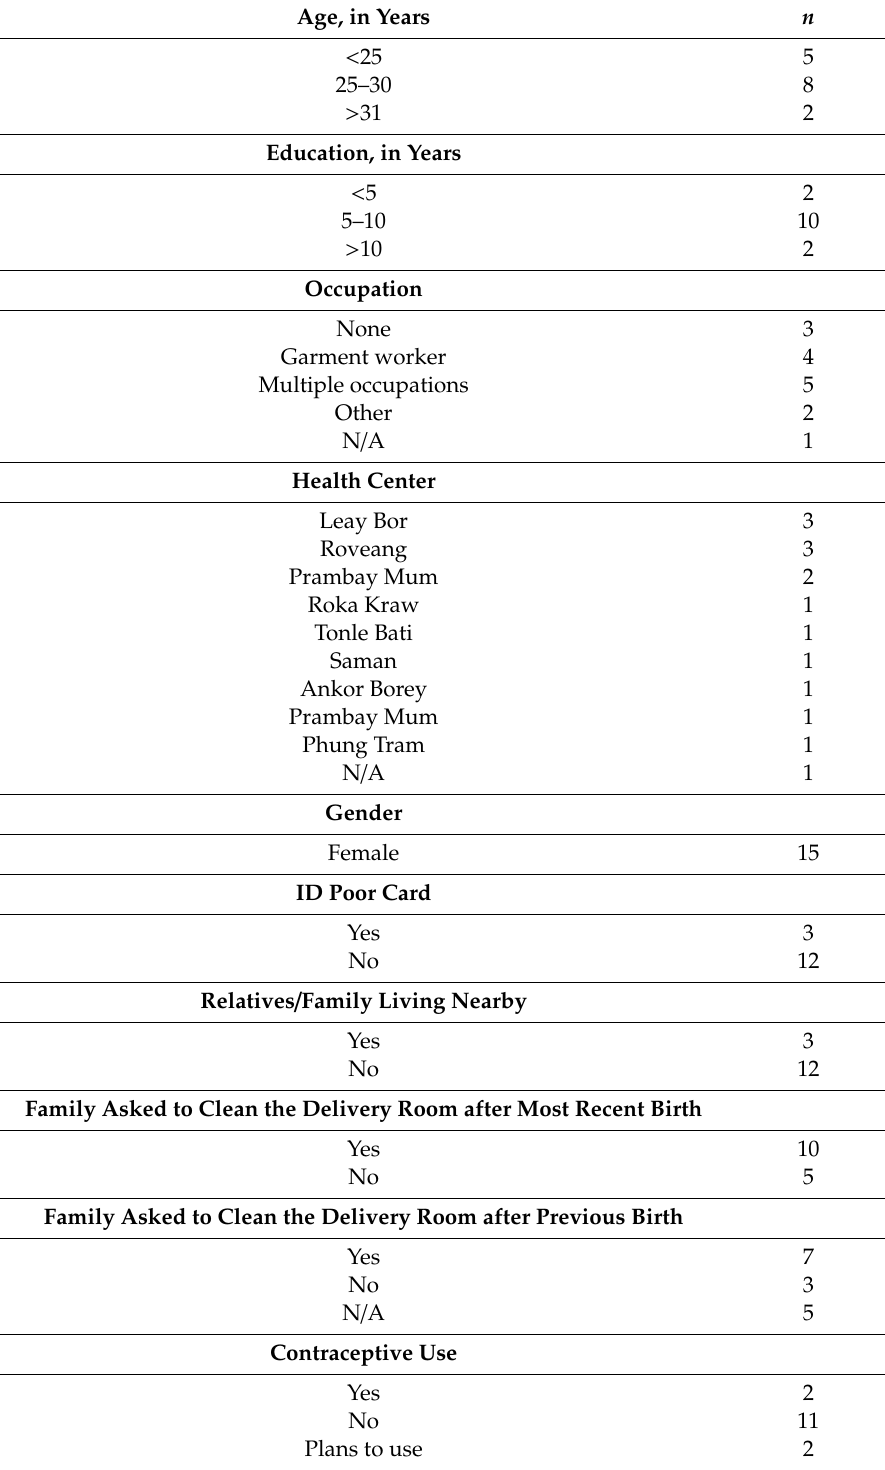
Table 3. Characteristics of interview participants: mothers ( N =